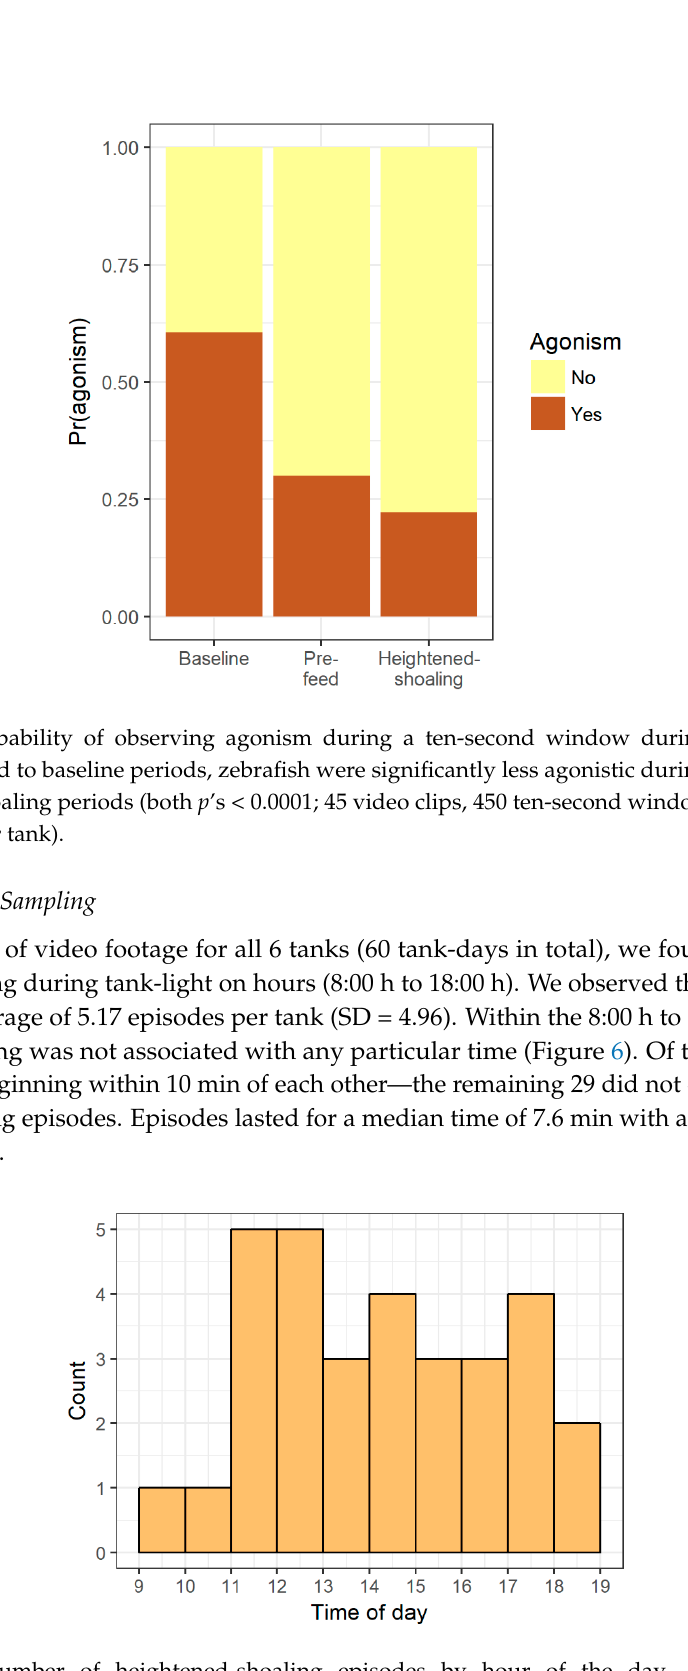
Figure 6. Number of heightened-shoaling episodes by hour of the day. We observed heightened-shoaling at least once in all six tanks and occurring throughout tank-lights on hours, but rarely (only once) in two tanks simultaneously (zebrafish housed in naturalistic tanks; n = 6 tanks, 10 zebrafish per tank; 10 days selected to observe from a 6-month period; 31 episodes of heightened-shoaling).